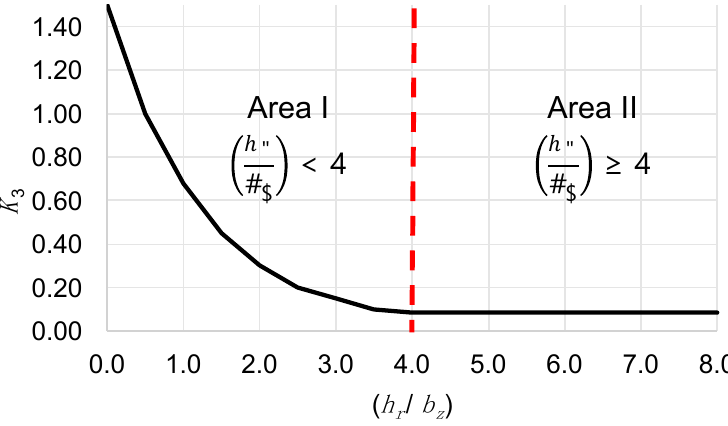
Figure 9. Coefficient K 3 (in accordance with Journal of Laws of 2000 No. 63, item 735 [11]. Figure 9. Coe ffi cient K 3 (in accordance with Journal of Laws of 2000 No. 63, item 735